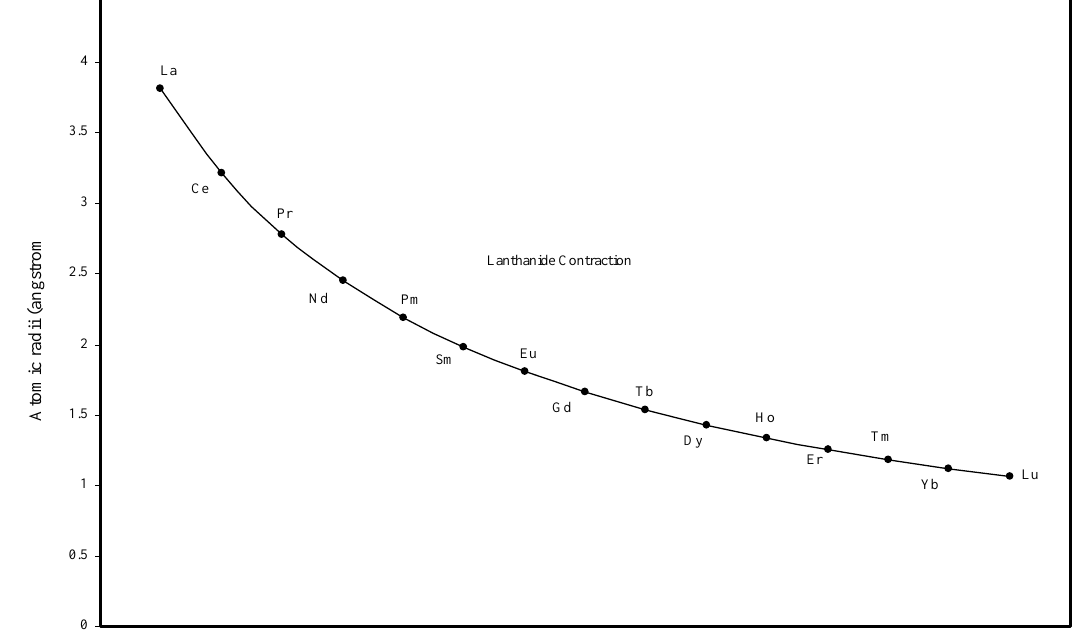
Figure 5. Plot of atomic radii of lanthanides in angstrom unit as function of atomic number.